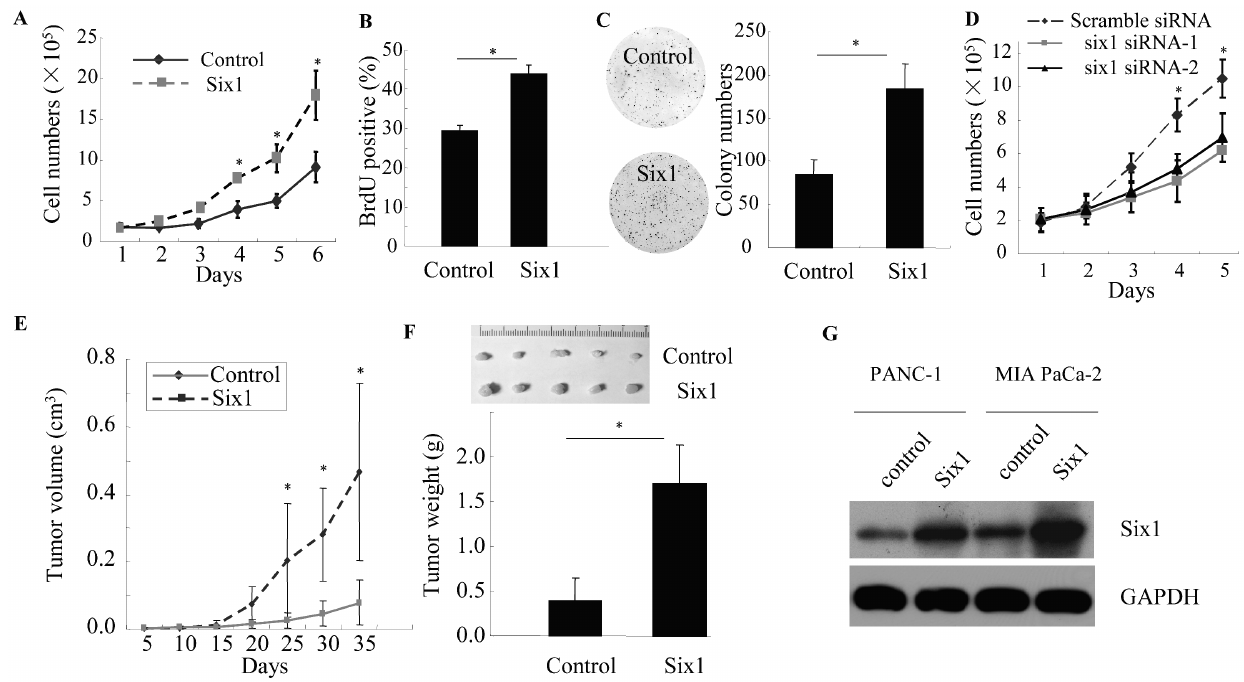
Figure 2. Six1 increases pancreatic cancer cell proliferation invitro and invivo . Cell numbers (A), percentage of BrdU positive cells (B) and number of colonies (C) of PANC-1 cells stably transfected with either Six1 or control plasmids. Solid line, control; dashed line, Six1. D, Number of PANC-1 cells transfected with Six1 siRNA and scramble control. Solid line, scramble control siRNA; dashed line, Six1 siRNA. E, Tumor size of subcutaneous xenografts measured within 5-day interval. The tumor volume was calculated using the formula: (Length 6 Width 2 )/2. F, Representative subcutaneous tumor xenografts generated in mice 5 weeks after inoculation (upper panel), and the weight of the tumors ( lower panel ). G, The expression of Six1 in both PANC-1 and MIA PaCa-2 cells was determined by western blot analyses. GAPDH was used as an internal control. All experiments were performed in triplicate; bars, s.e.m.; * P , 0.05.